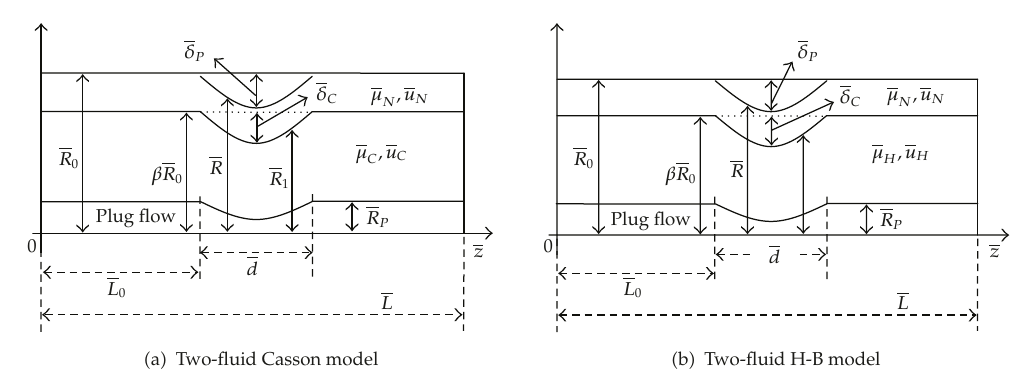
Figure 1: Geometry of the two-fluid models with arterial